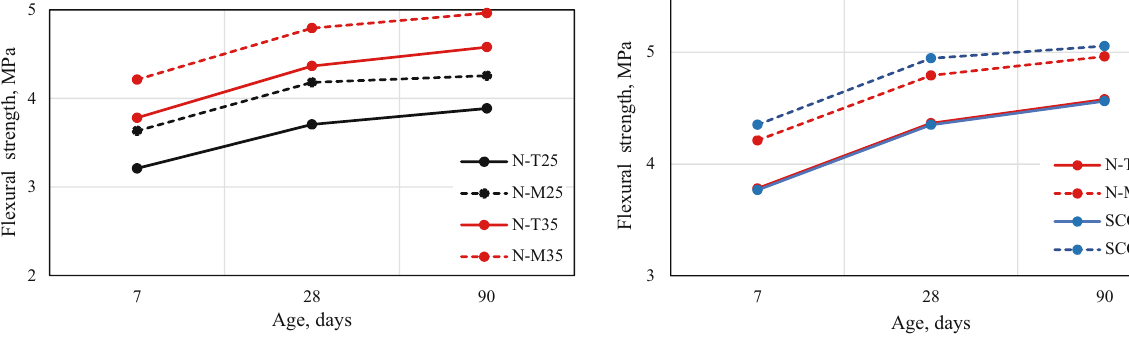
Figure 6: Flexural strength results for normal mixes using tap and magnetized water.